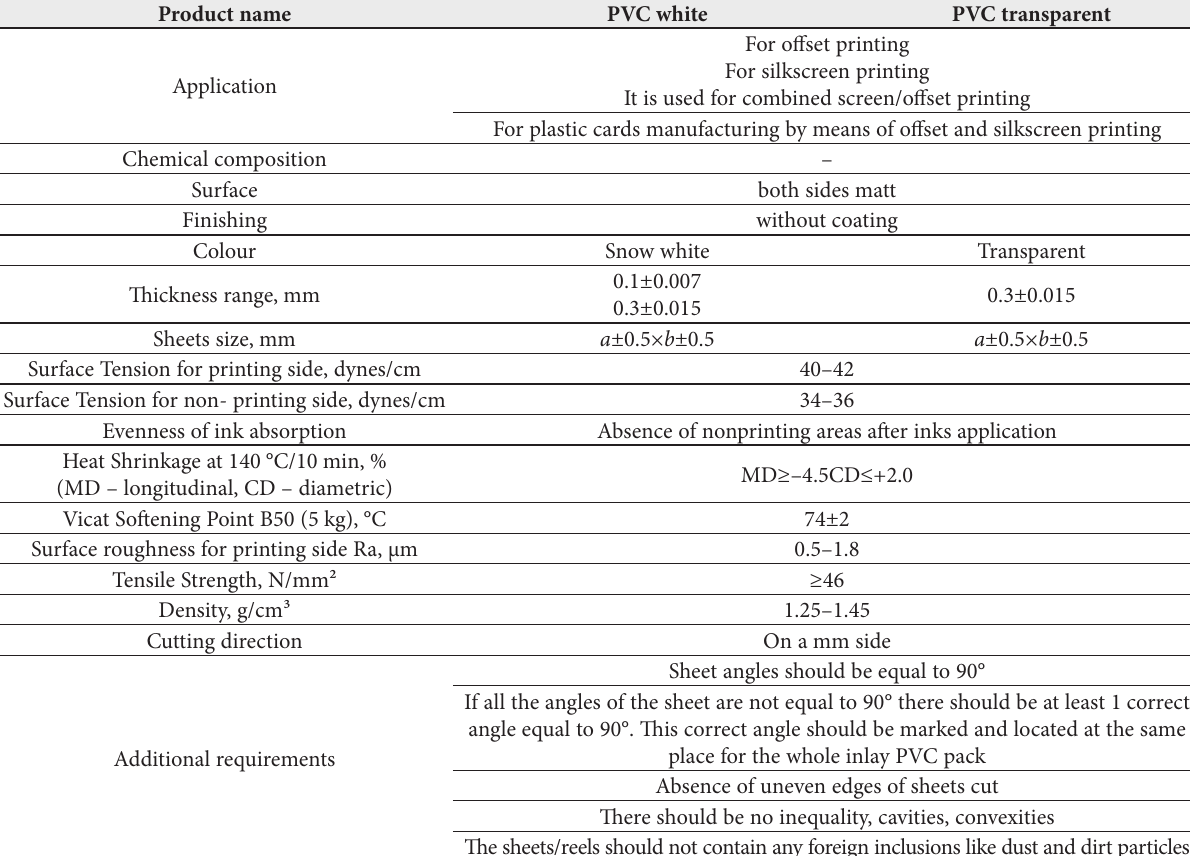
PVC characteristics that are recommended to be monitored during the incoming inspection of the